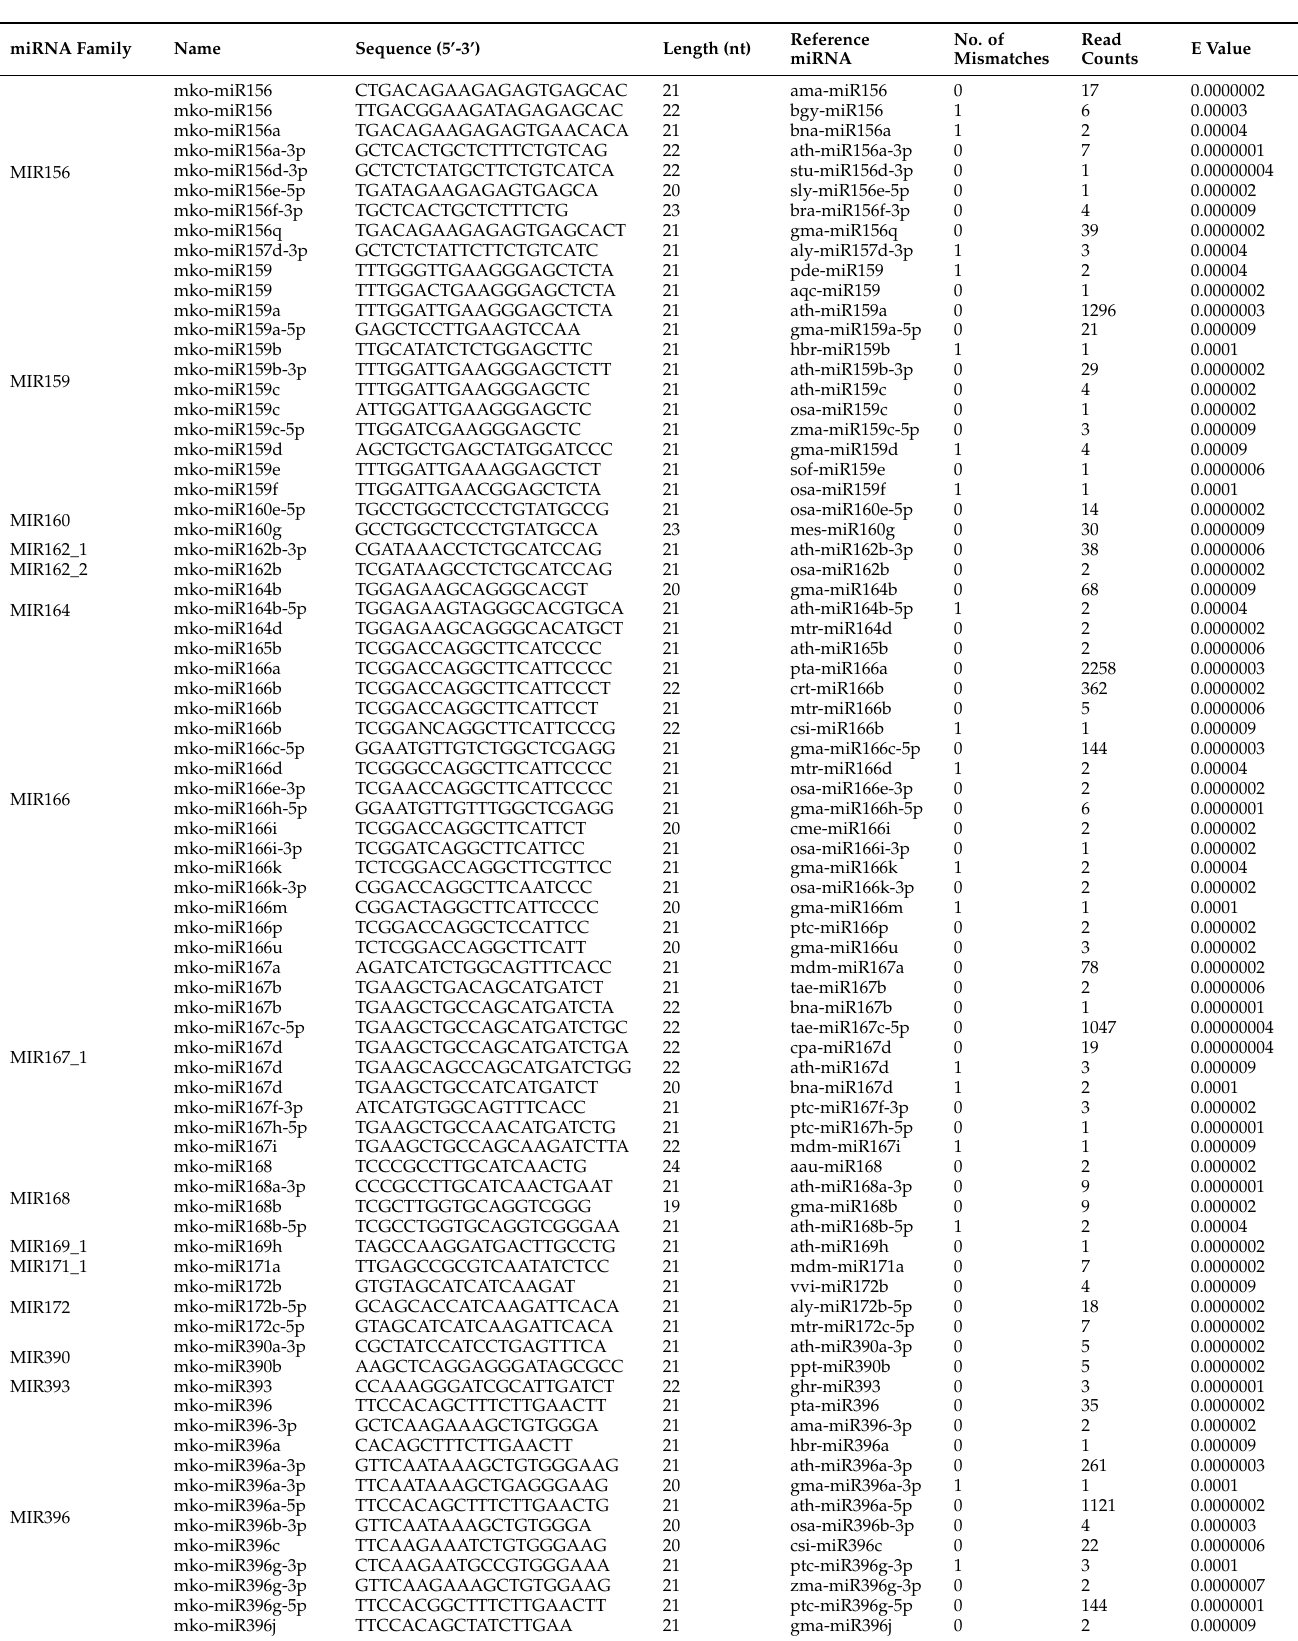
Table 2. Summary of M. koenigii conserved